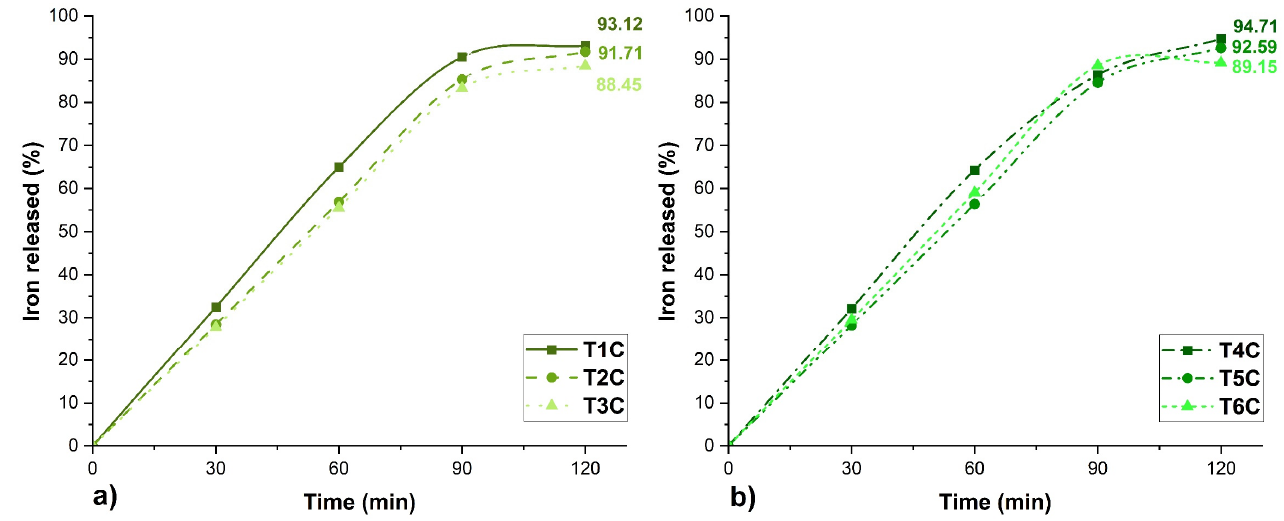
Figure 9. Erythrocyte encapsulations, ( a ) encapsulated at 120 °C and ( b ) encapsulated at 140 °C.